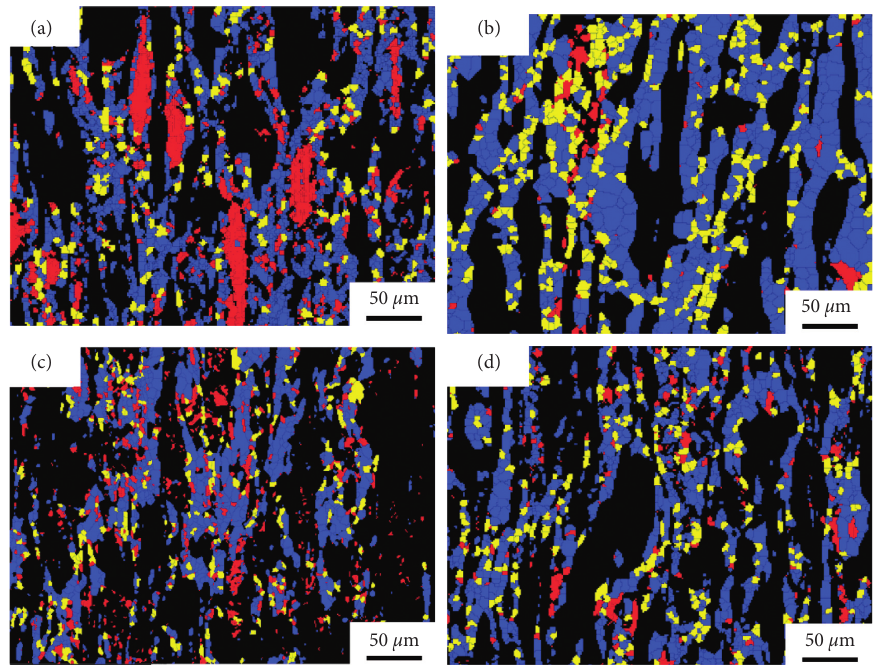
Figure 8: Different types of grains of (a) MYZ, (b) MYZC, (c) MYZN, and (d) MYZCN extruded the structure of the bulk LPSO phase is different from the diffusion of solid solution atoms and then promotes the 18R-type in the as-cast alloys [13], which is due to the fact that nucleation and growth of long-period structures [20]. In this when the temperature is over 500 ° C, the 18R structure will be work, it can be observed that the bulk LPSO phase and the lamellar LPSO phase in extruded alloys (Figure 5) are both transformed into 14H structure [23, 24]. Most studies show 14H-type LPSO phase. The lamellar 14H phase is precipitated that higher temperature and longer heating time can greatly from α -Mg matrix during the heat treatment [21, 22]. While increase the volume fraction of the 14H phase [25].